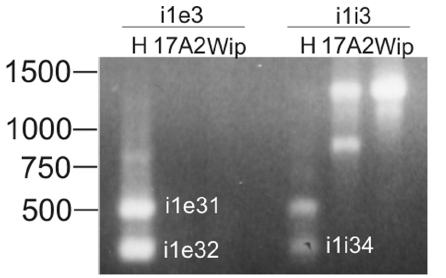
Fig. 3 – Agarose gel electrophoresis with RT-PCR products from embryos of D. melanogaster (H) and D. willistoni (17A2 and Wip). The first step of cDNA amplification was carried out with meli1+ and mele3-primers. (i1e3)RT-PCRwithmeli1+andmele3-primers. (i1i3) PCR reamplification with meli1+ and meli3- primers. The arrow in- dicates the transposase fragment. The fragments indicated by i1e31, i1e32 and i1i34 were gel-purified and sequenced. A 1-kb DNA ladder is depicted on the